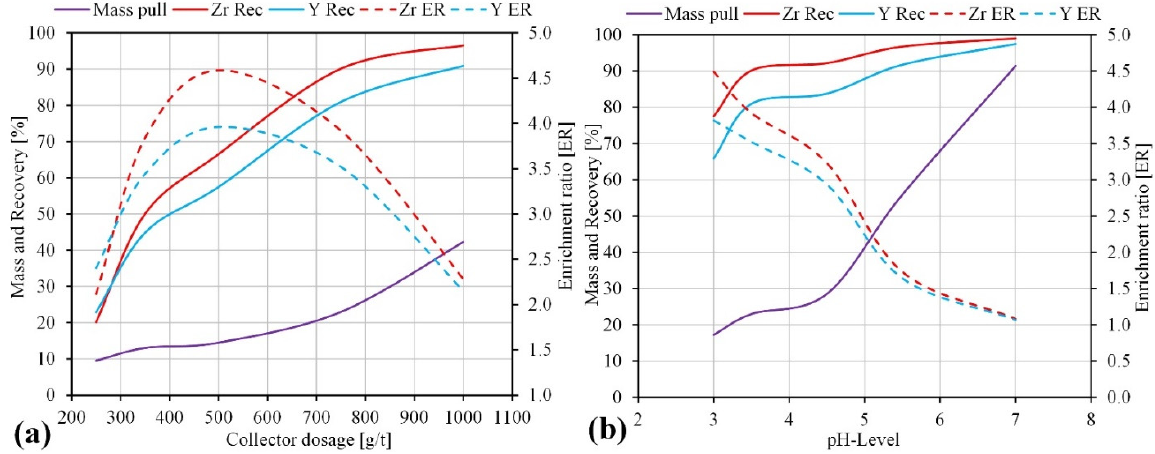
Figure 8. Flotation recovery and enrichment ratio as function of collector dosage ( a ) and pH level ( b